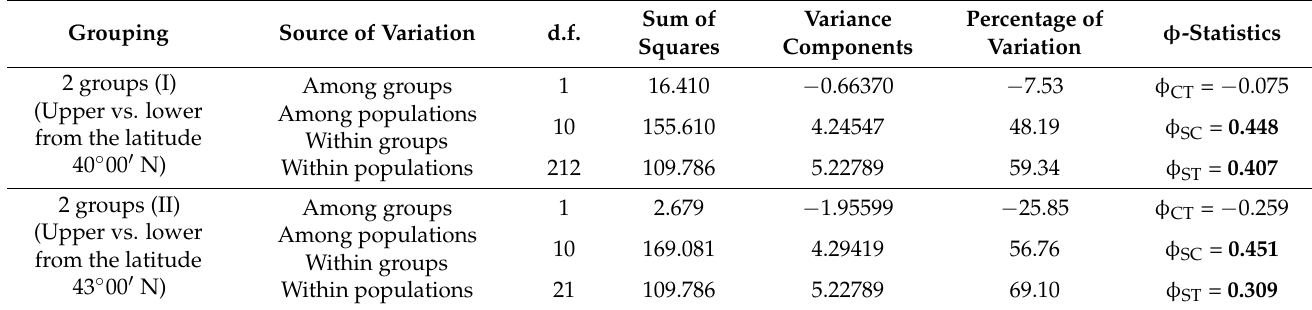
Table 2. Analysis of molecular variance (AMOVA) of C. relictus in Northeast Asia. Significant p -values ( p < 0.05) are indicated in